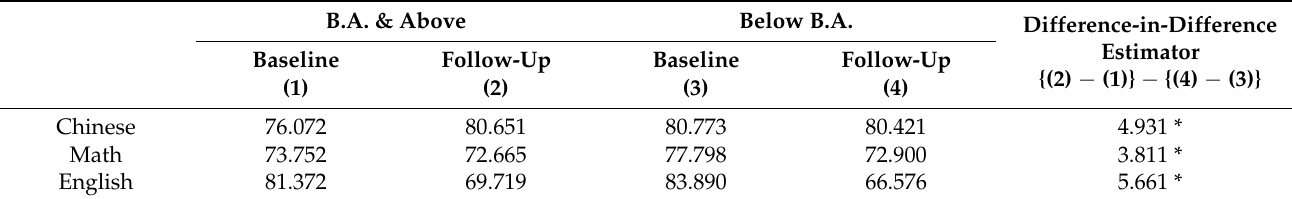
Table 2. Baseline and follow-up test scores by teacher educational attainment (N = 3436). B.A. & Above Below